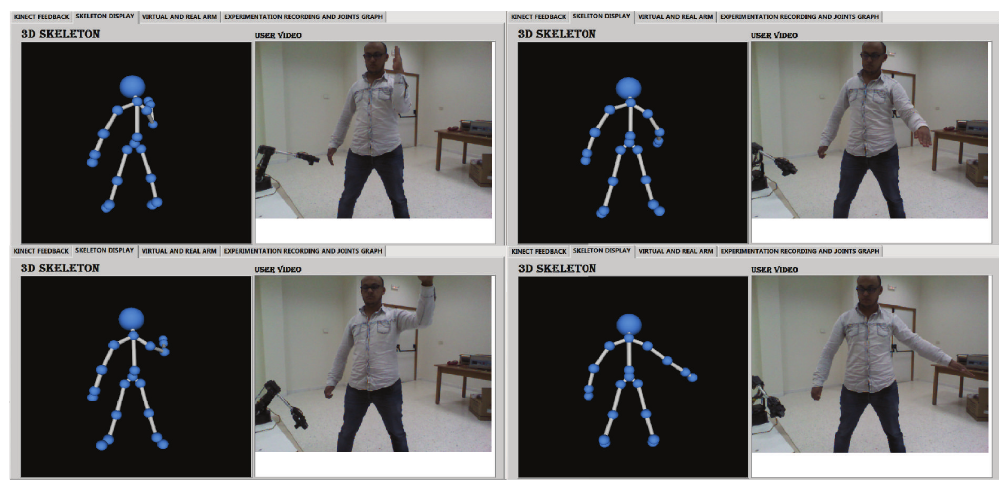
Figure 13: User and skeleton